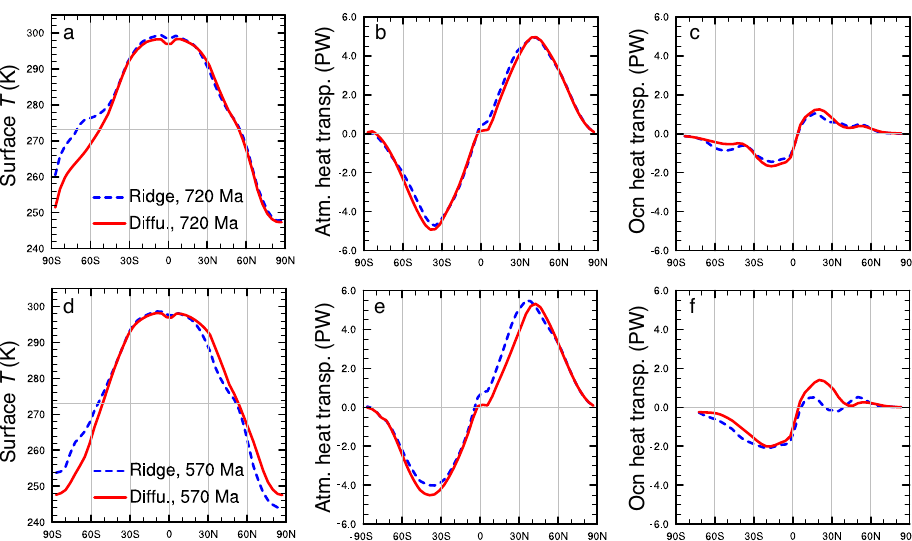
Fig. A3. Comparison of zonal mean surface temperature ( a and d ), atmospheric ( b and e ) and oceanic ( c and f ) heat transport obtained by employment of the RIDGE method and the DIF method. Upper and lower panels show results for the 720Ma and 570Ma continental configurations, respectively. TSI = 0.94TSI 0 , τ = 0 . 12, p CO 2 = 140 ppmv for all 4